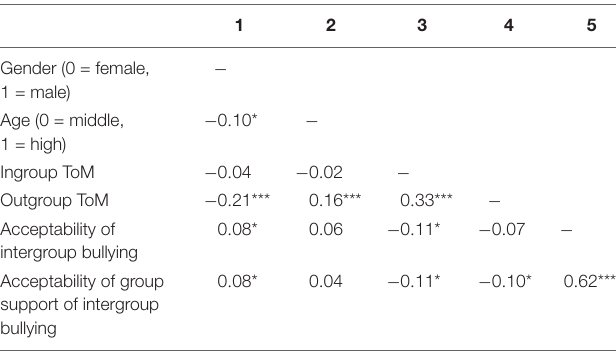
TABLE 2 | Correlations among study